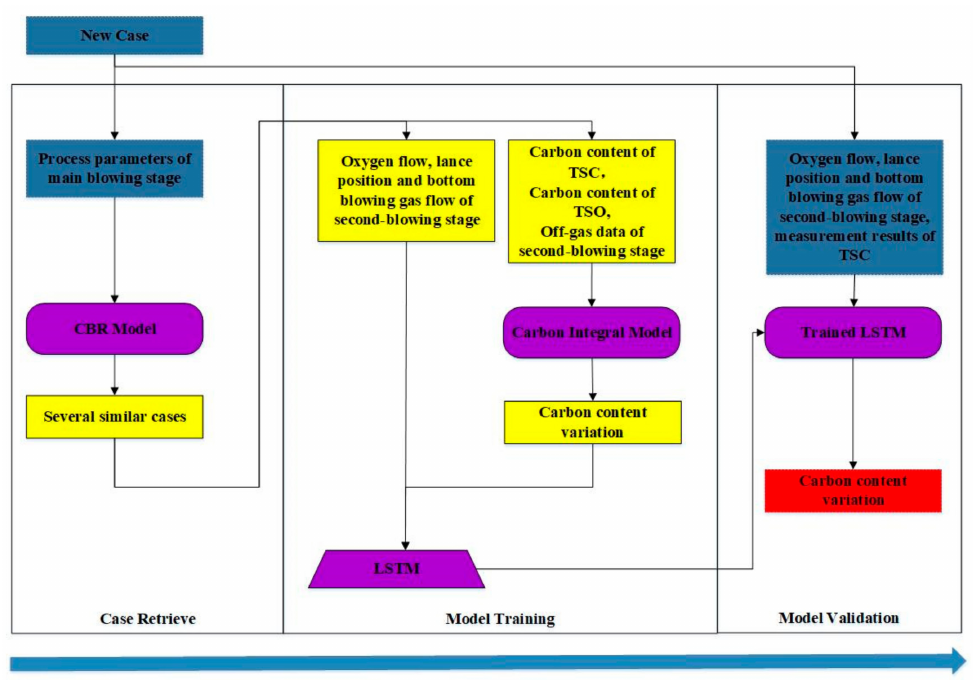
Figure 6. Process of the model.